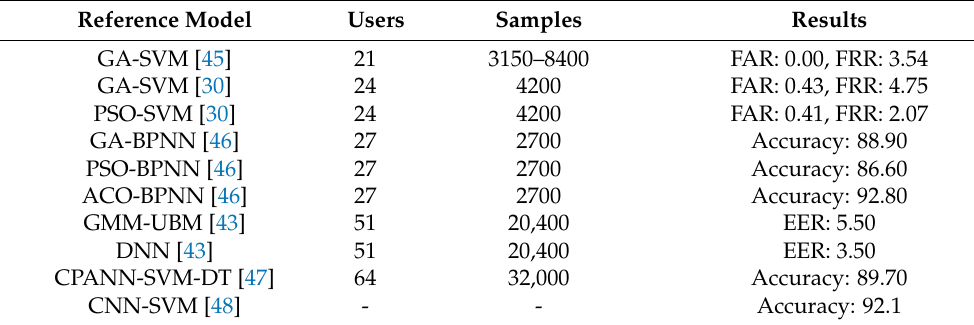
Table 3. Comparison of existing hybrid approach-based research in KB